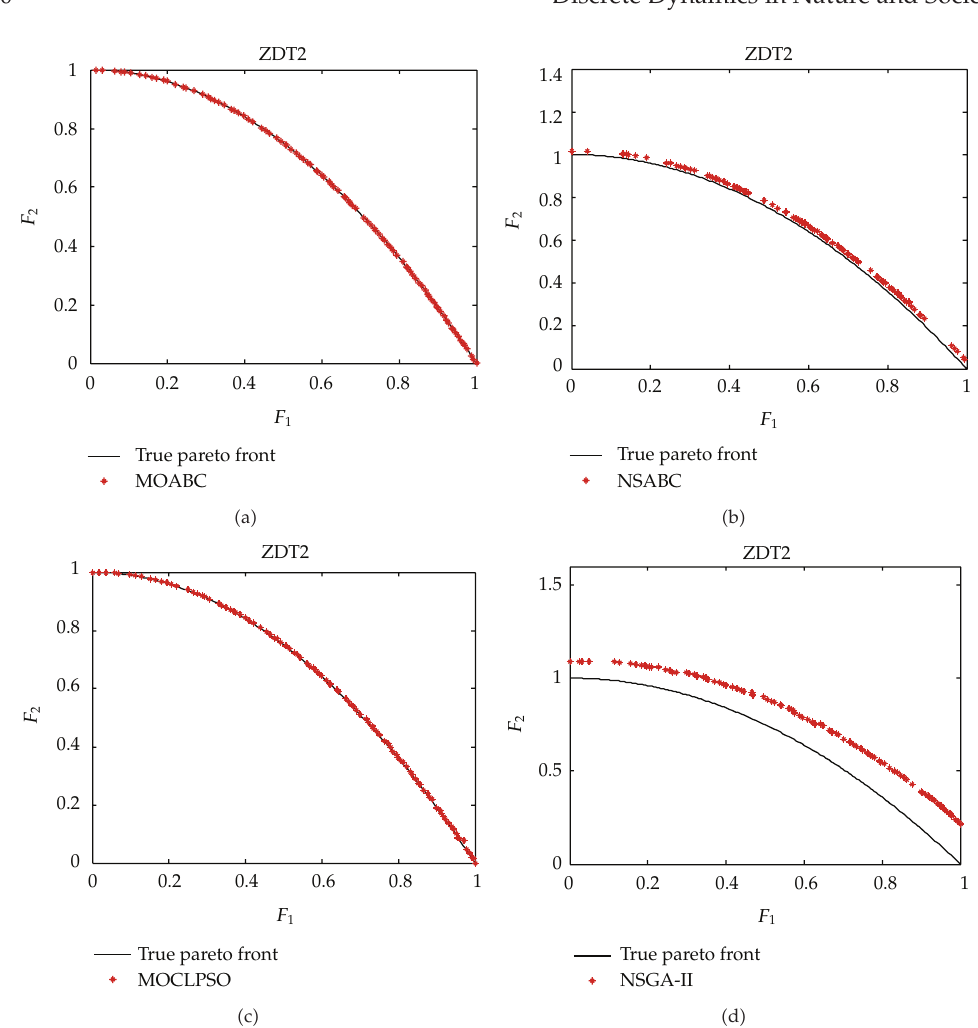
Figure 9: Pareto fronts obtained by NSABC, MOABC, MOCLPSO, and NSGA-II on ZDT2 after 20000 FEs.